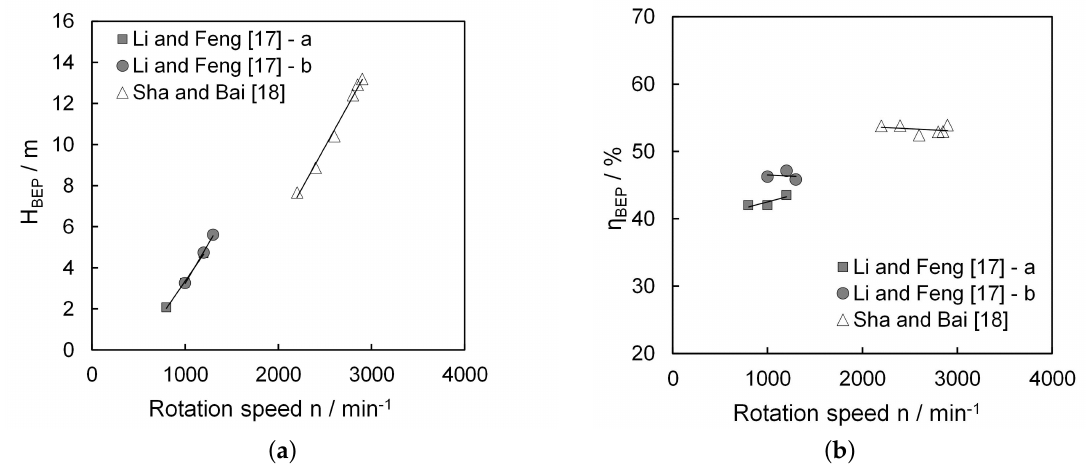
Figure 21. ( a ) Head over rotation speed; and ( b ) efficiency over rotation speed.